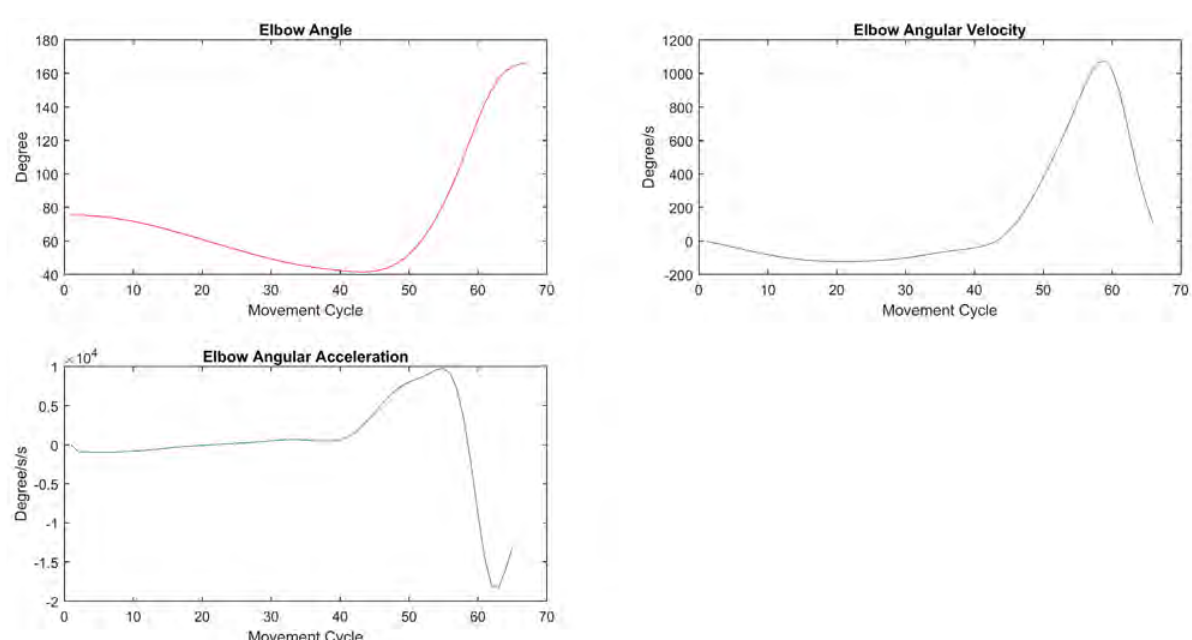
Figure 3. Respectively, the elbow angle curves, angular acceleration and angular velocity of the elbow marker. Landmarks A to E are calculated according to the first landing and the last peak in each curve (Breslin et al,